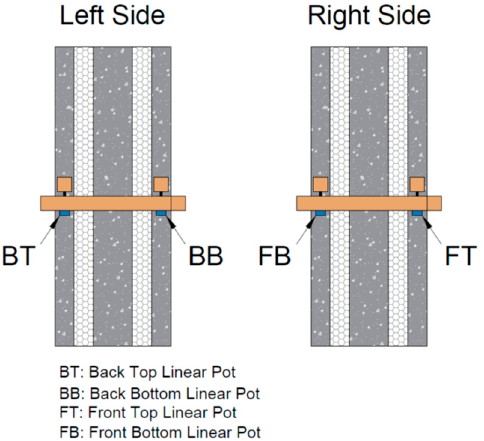
Figure 5. Locations of linear potentiometers for all tests.